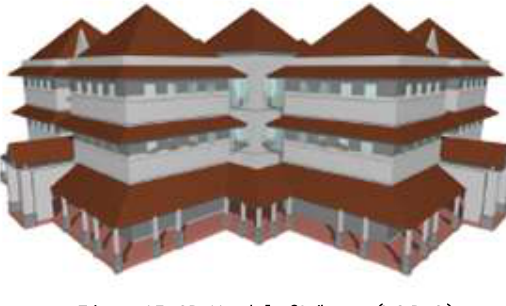
Figure 15. 3D Model of Library (LOD